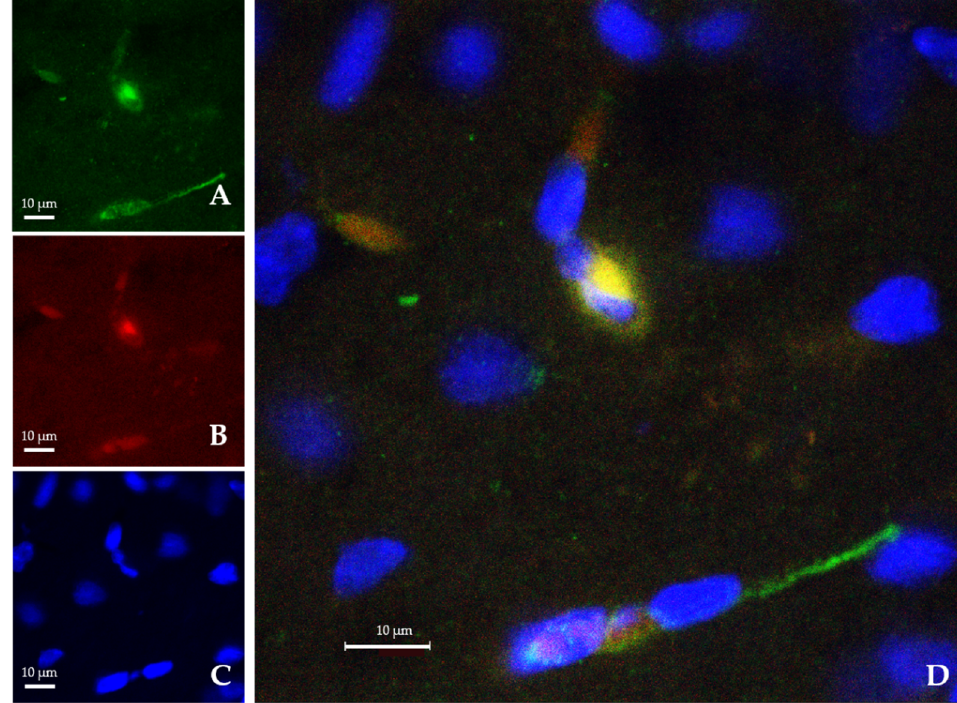
Figure 4. Confocal microscopy images from the infarcted zone of MCAO animals taken 24 h after the systemic injection of the Ngb-NPs. ( A ) Cy2 green fluorescence represents Ngb. ( B ) Rhodamine red fluorescence detects NPs. ( C ) DAPI blue fluorescence marks cell nuclei. ( D ) Merge image showing the colocalization of Ngb and NPs inside the nervous cells. Ngb attached to NPs appears in yellow, due to green and red merge.